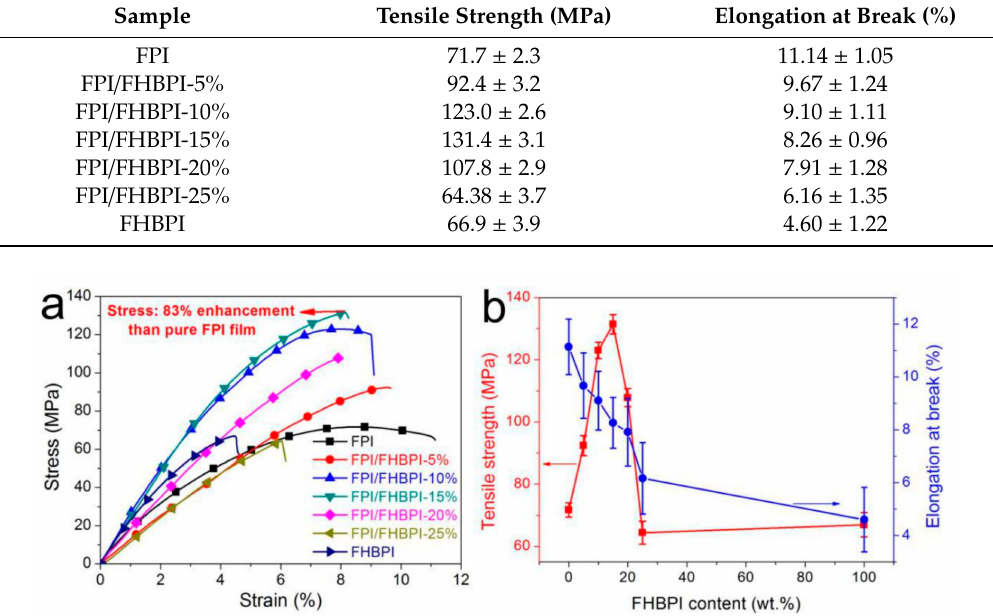
Table 2. Tensile strength and elongation at break of FPI, FPI / FHBPI composites and FHBPI.